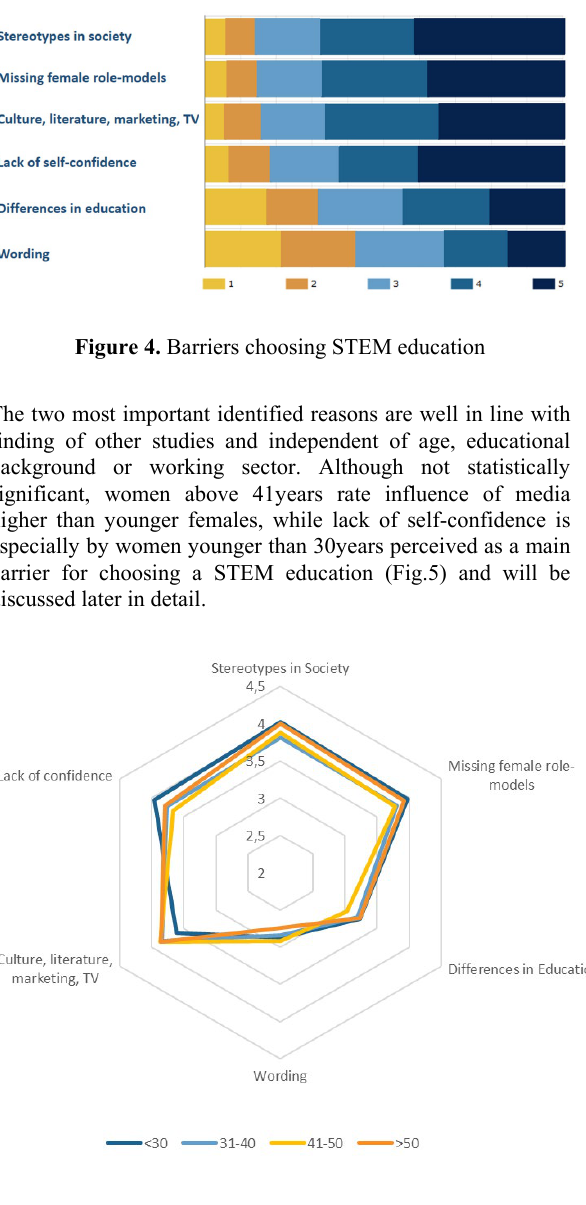
Figure 5 . Barriers choosing STEM education depending on